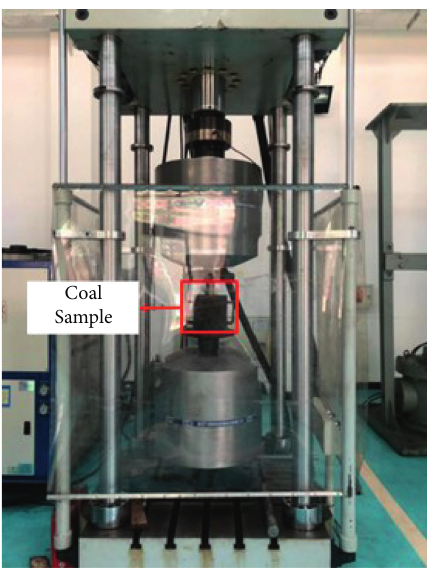
Figure 1: Fatigue testing